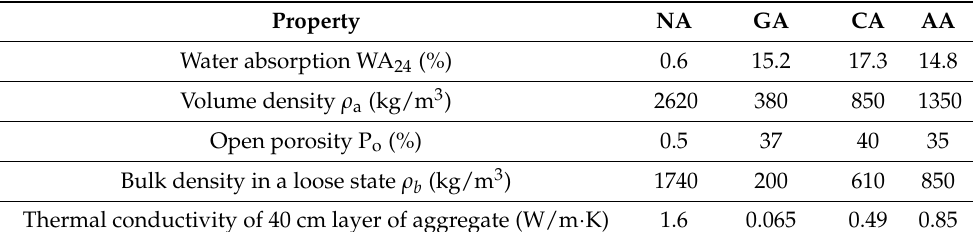
Table 3. Physical properties of the aggregates [48–50].